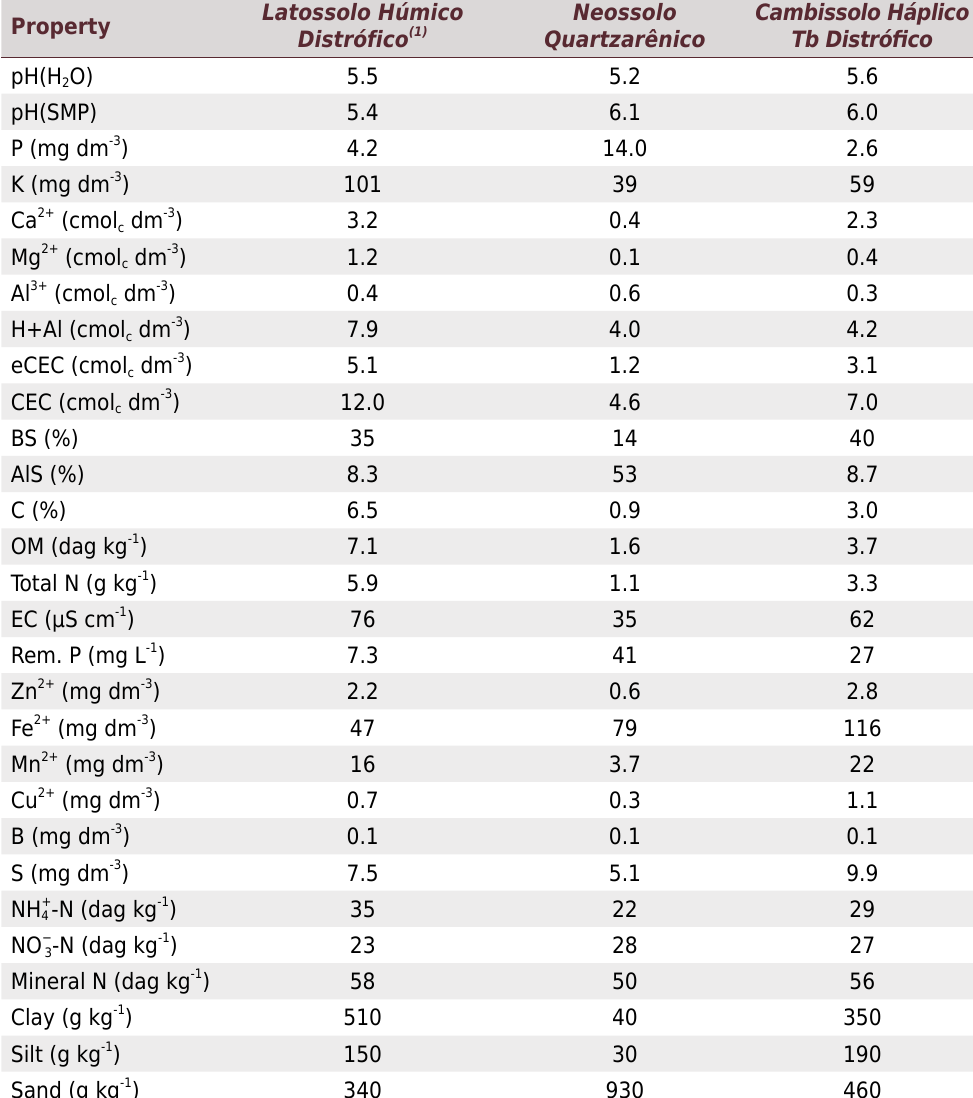
Table 1. Fertility properties, electrical conductivity (EC), and granulometry of the three studied